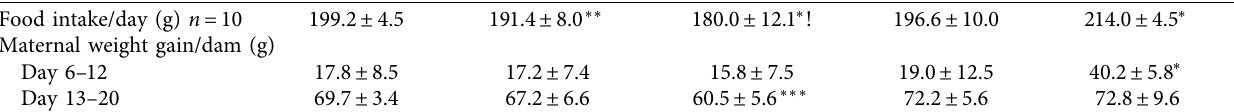
Table 1: Maternal weight gain and food intake of pregnant rats treated with 70% ethanol leaf extract of Syzygium guineense . Weight gain and food intake